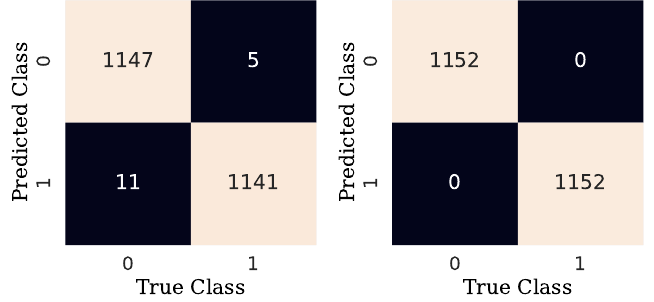
Figure 17. Confusion matrices for damage detection models 1 ( left ) and 2 ( right ) when using a data split of 70% training, 15% validation, and 15% for